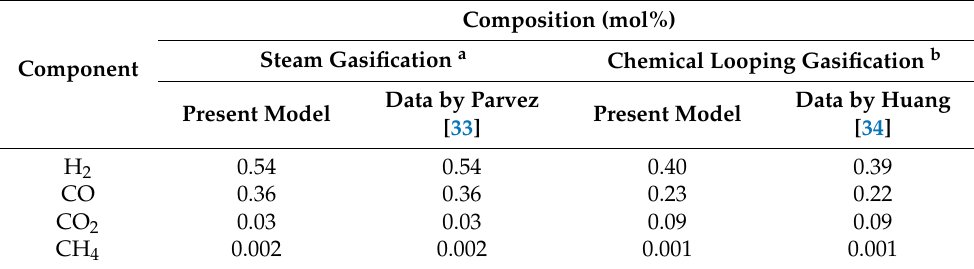
Table 3. Verification of gasification gas composition.